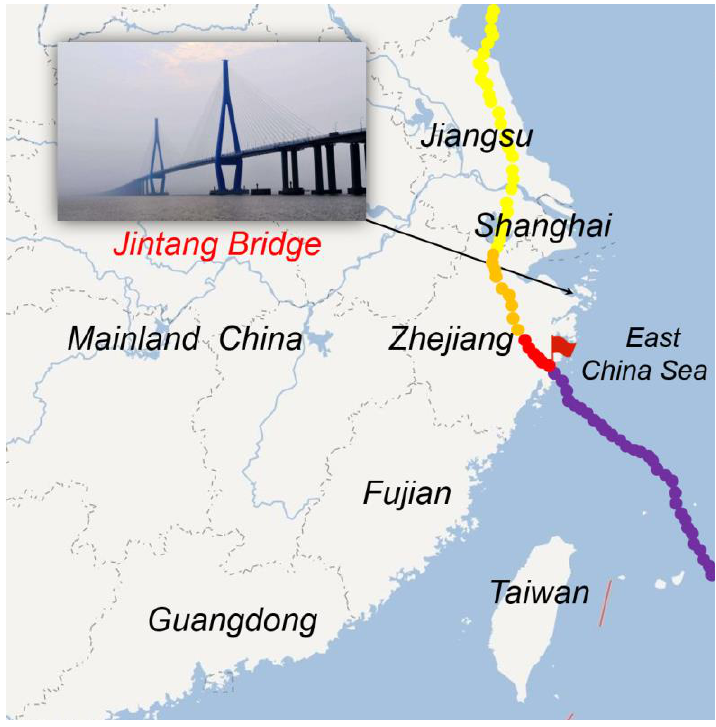
Figure 1. Moving track of Typhoon Lekima.